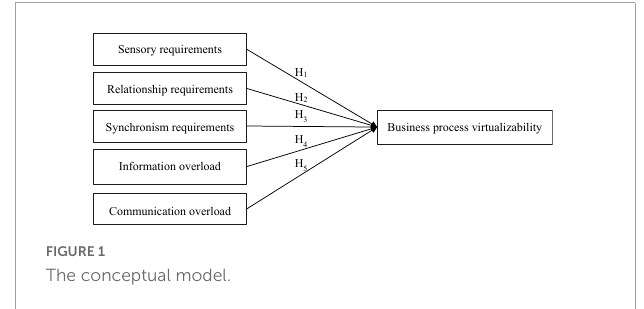
FIGURE1 The conceptual